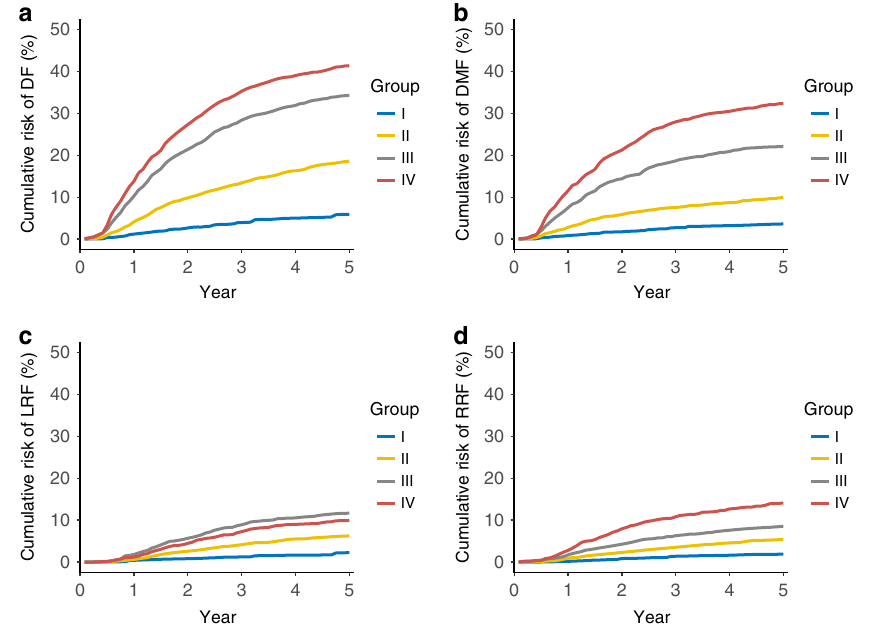
Fig. 1 Risk-adjusted survival curves of different staging groups in nasopharyngeal carcinoma patients. Disease failure probabilities ( a ); distant metastasis – free survival probabilities ( b ); local recurrence – free survival probabilities ( c ) and regional recurrence – free survival probabilities ( d ). Number of patients: group I, n = 367; group II, n = 3472; group III, n = 1863; group IV, n = number divide by the total patients at risk (Supplementary